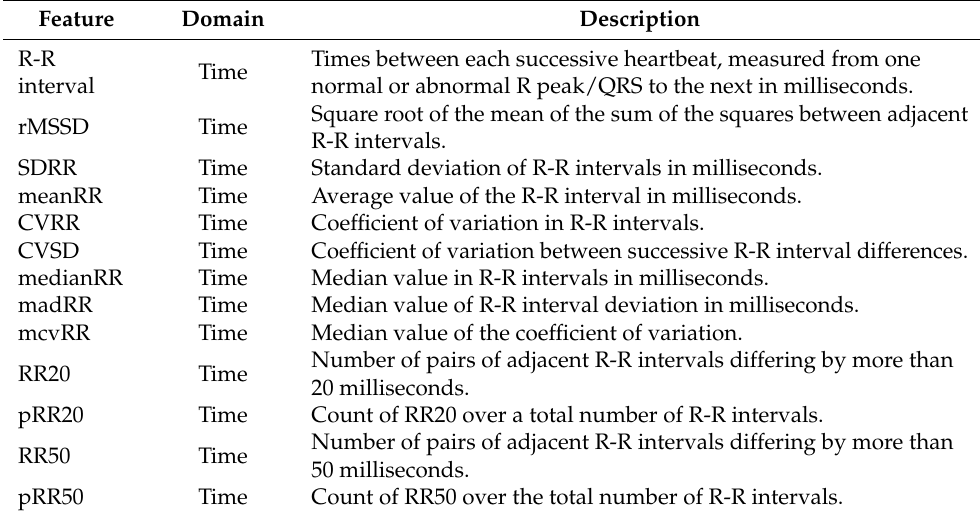
Table 1. A summary of the HRV feature characteristics used in this work.